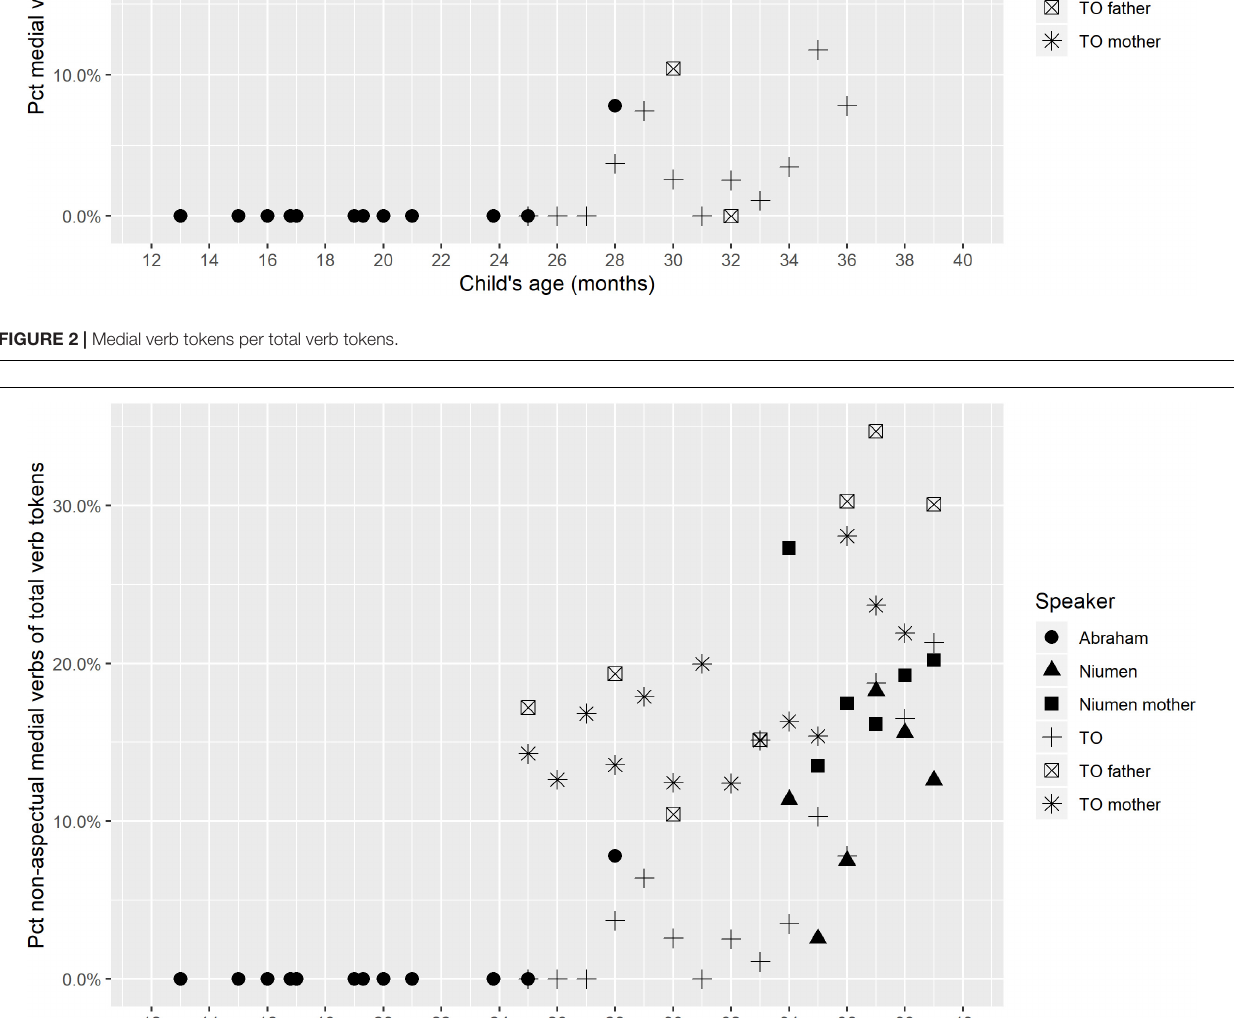
trend, but TO’s use in the same age range does not show any indication of this. In the very first transcripts with medial verb productions for TO and Niumen, all their medial verbs